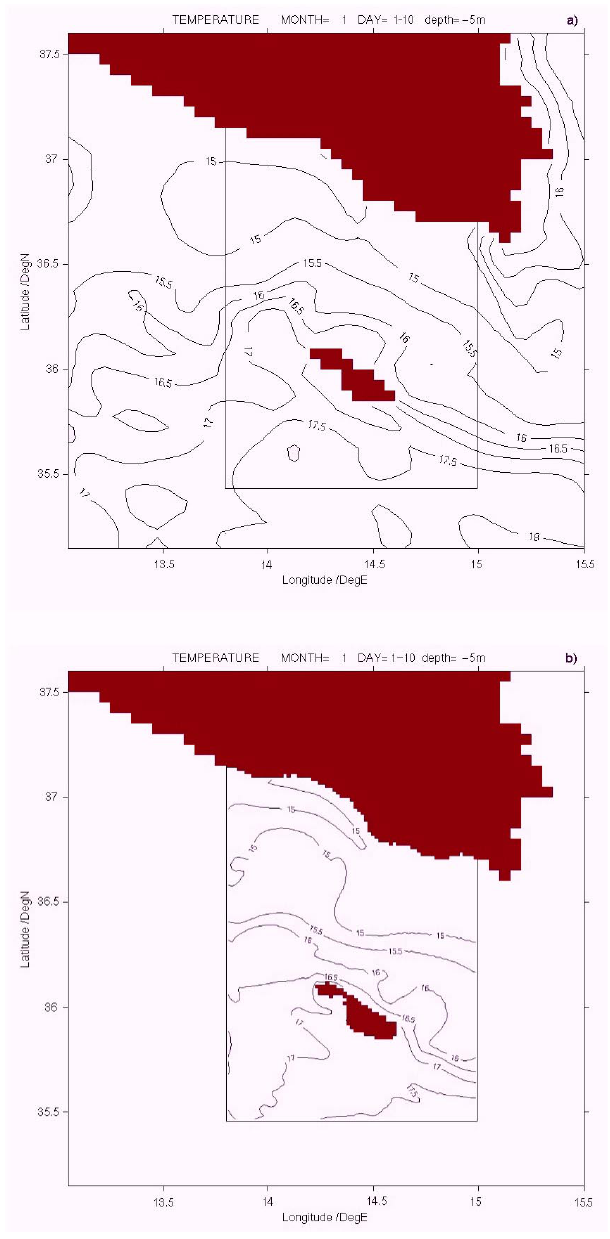
Fig. 9. Comparison of the 10-day averaged temperature horizontal field at 5m depth in January simulated by (a) the coarse resolution model and (b) the benchmark high resolution shelf model.